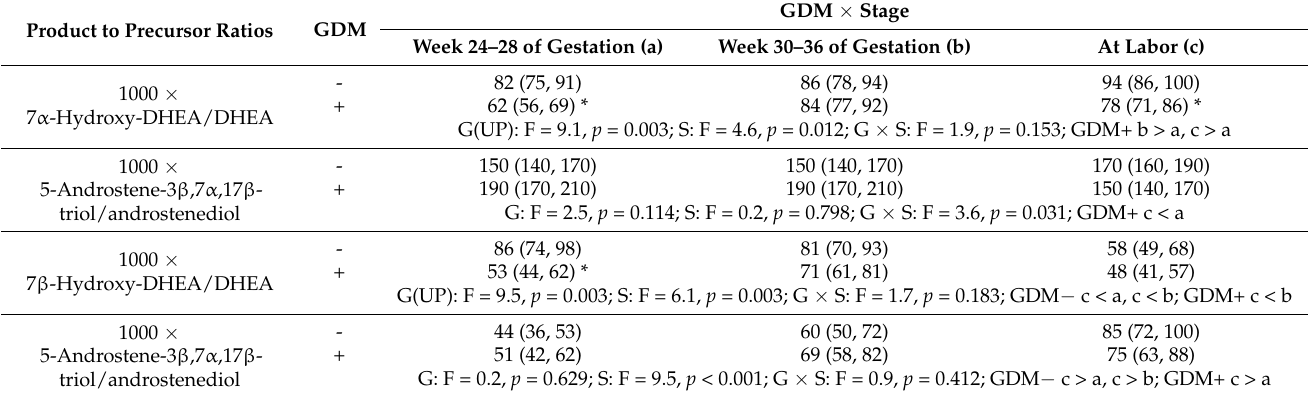
Table 8. Profiles of product to precursor ratios that may reflect the conversion of adrenal androgens to their 7 α / β -hydroxy- derivatives in the GDM − and GDM+ groups from week 24 of gestation to